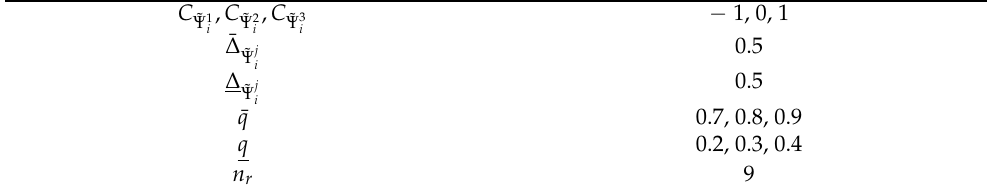
Table 1. FLS parameters.